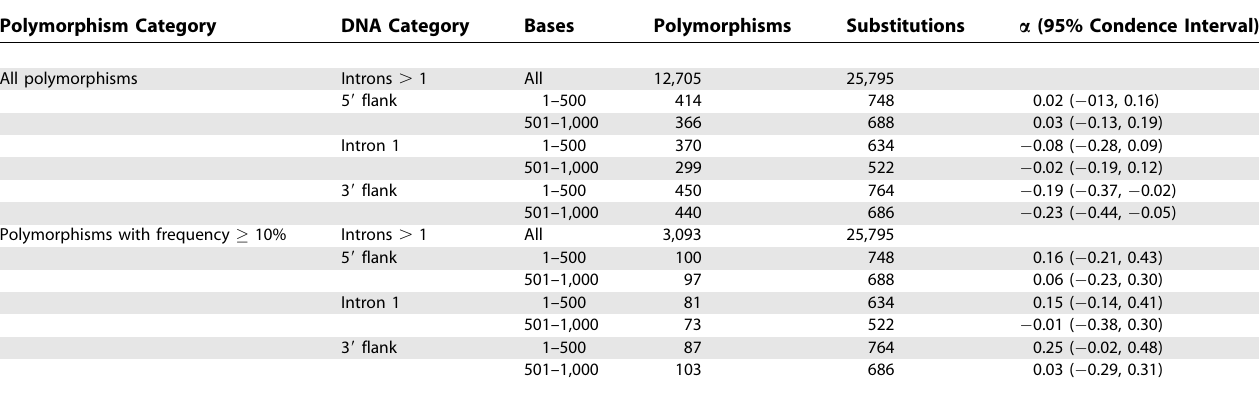
Table 3. Tests of Adaptive Evolution for 5 9 , 3 9 , and Intron 1 Sequences in Hominids Polymorphism